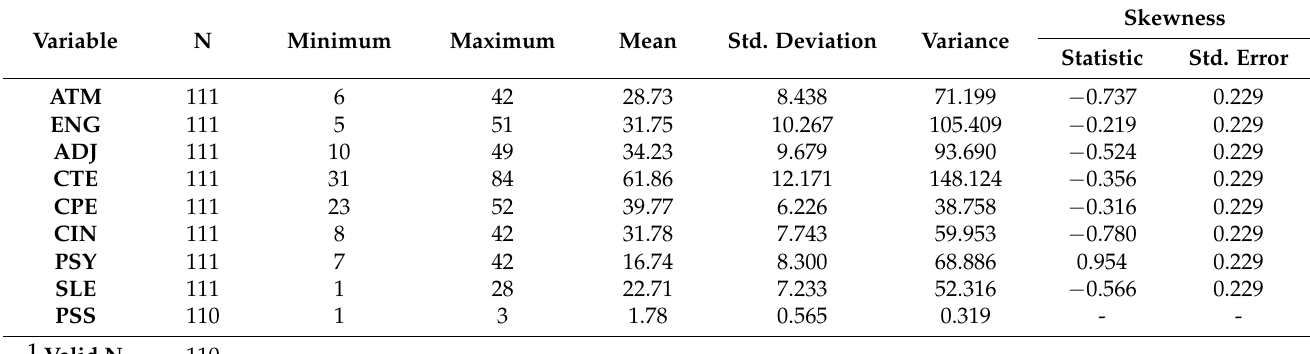
Table 2. Descriptive statistics for continuous